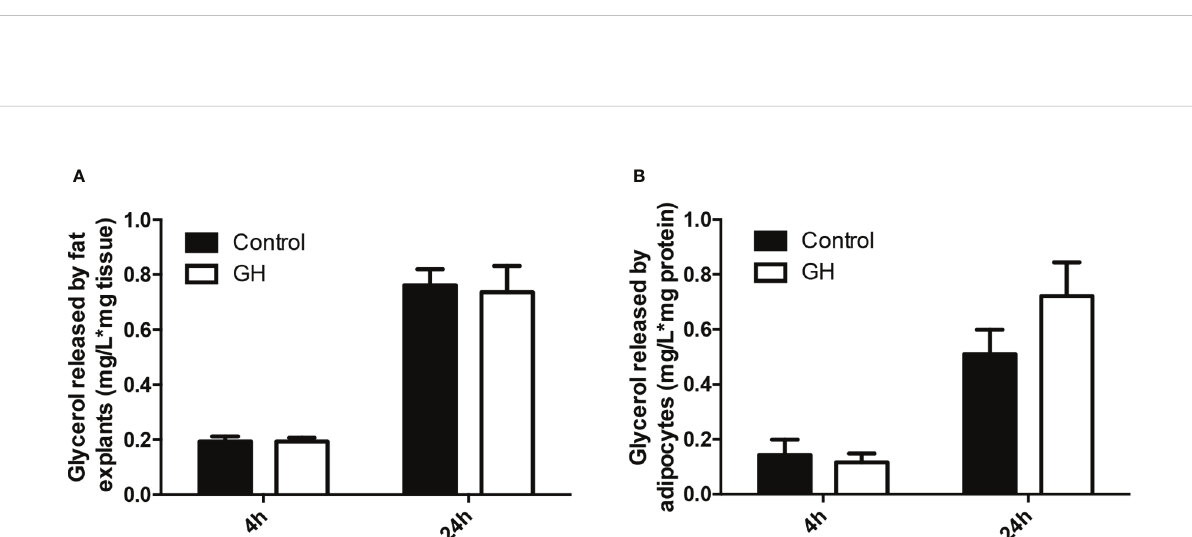
FIGURE 5 Effect of GH on lipolysis in adipose tissue and adipocytes. (A) Effect of GH on lipolysis in adipose tissue explants. Inguinal subcutaneous fat explants from ad lib-fed lit/lit mice were cultured with vehicle control or 100 ng/ml GH for 4 h and 24 h, and glycerol concentration in the medium was measured. Concentration of glycerol in the medium was normalized by the mass of adipose tissue. (B) Effect of GH on lipolysis in adipocytes. The stromal vascular fraction cells were isolated from ad lib-fed lit/lit inguinal subcutaneous fat and differentiated into adipocytes in culture. Adipocytes were then treated with control or 100 ng/ml GH for 4 h and 24 h. Glycerol concentration was normalized by total protein content of adipocytes. Data are expressed as mean ± SEM (n = 5 mice). Both 4-h and 24-h GH treatments had no effect ( P > 0.1) on glycerol release from either adipose tissue or adipocytes. * represents